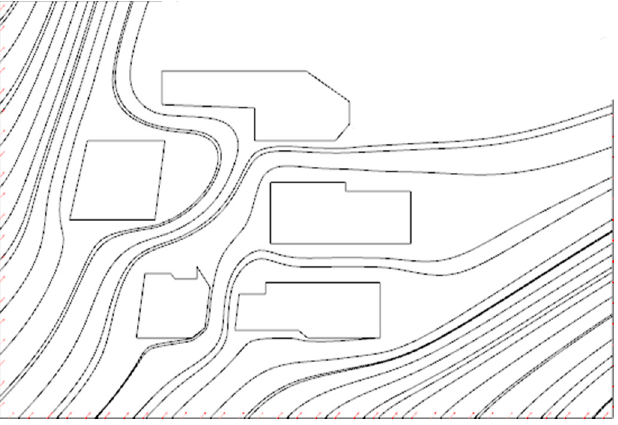
Figure 17. Air-borne particle paths going through ten sensors in a real map processed by COMSOL.